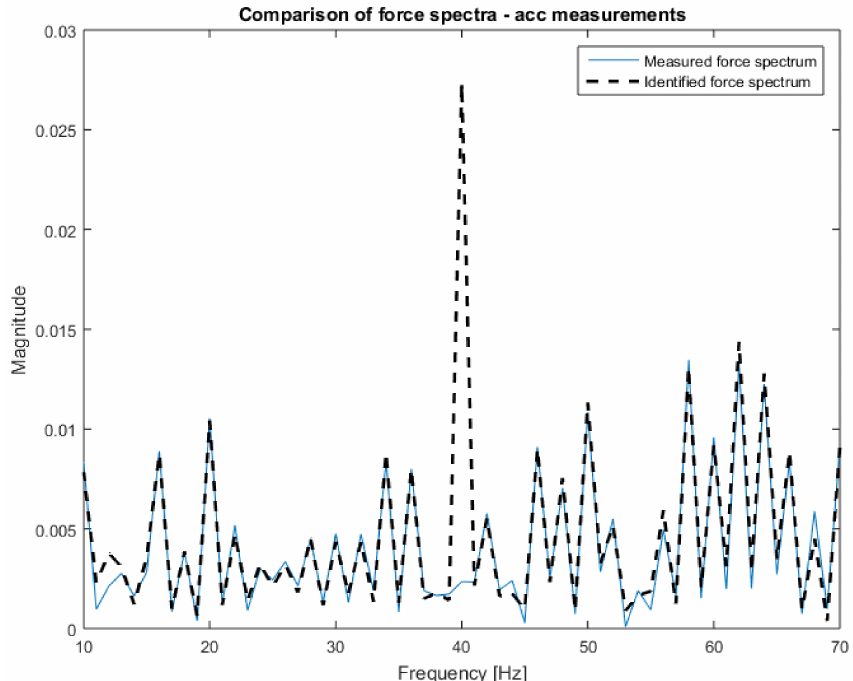
Figure 9. Comparison of measured and identified force spectra for the vibrations’ acceleration measurements (narrowed frequency